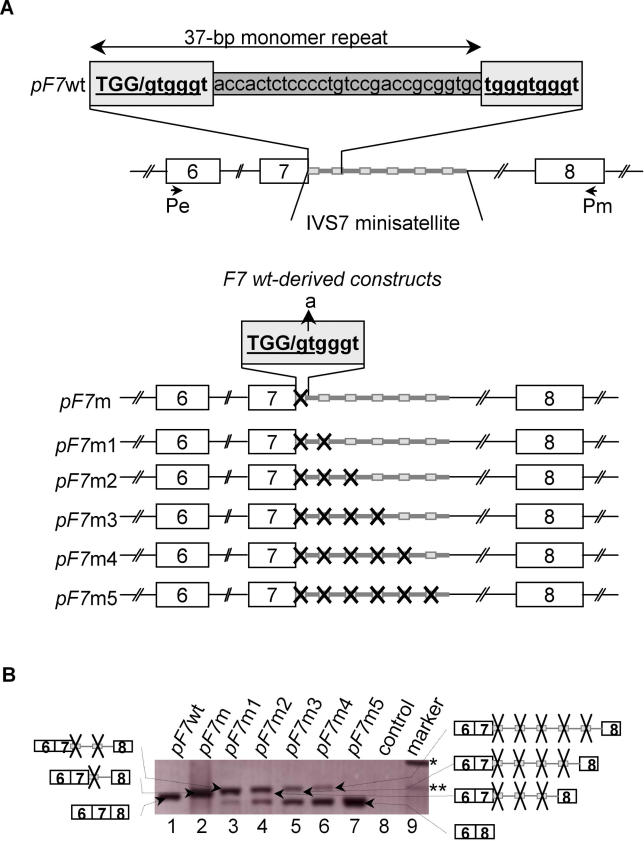
Assessment of the Ability of the IVS7 Pseudo-Sites to Be Activated(A) Schematic representation of the constructs used in this experiment. Top: Organization of the wild-type F7 IVS7 proximal region (pF7wt); exons and introns are represented by open boxes and thin lines, respectively. The first 37-bp monomer, which spans the exon7–IVS7 boundary, is repeated within IVS7. The monomers are represented by a thick grey line. Each pseudo-splice site is represented by a grey box, and is separated from the next one by 28 bp. Bottom: Schematic representation of the various F7 minigenes carrying a T-to-A transition located at the main dinucleotide of the consensus donor splice site and involving several consecutive 37-bp monomer elements found in IVS7. Mutations are represented by a black cross.(B) RT-PCR amplification of F7 transcripts isolated from CHO cells transfected with the above-mentioned constructs. The products corresponding to the different PCR fragments, as identified by sequencing, are schematically represented on both sides of the figure.